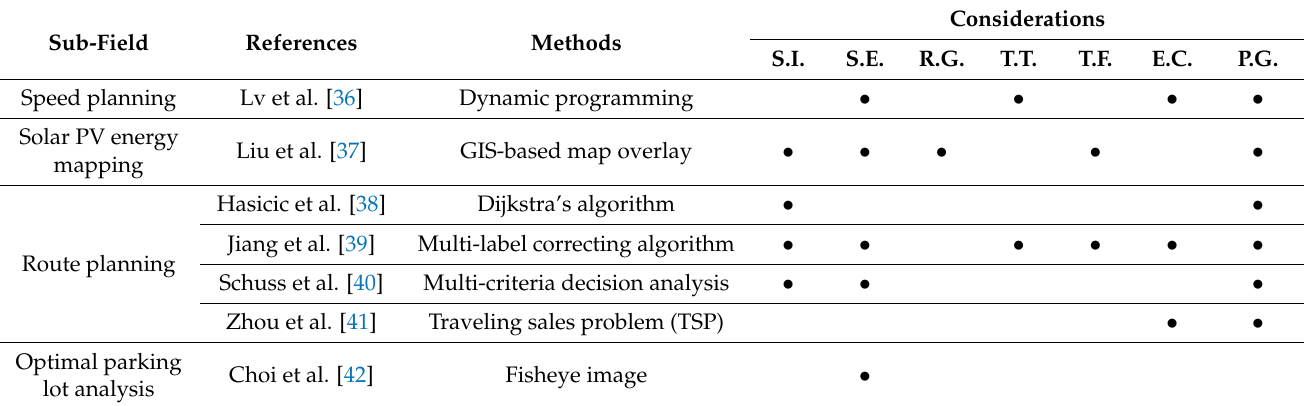
Table 1. Summary of previous studies on software technologies for SPEV